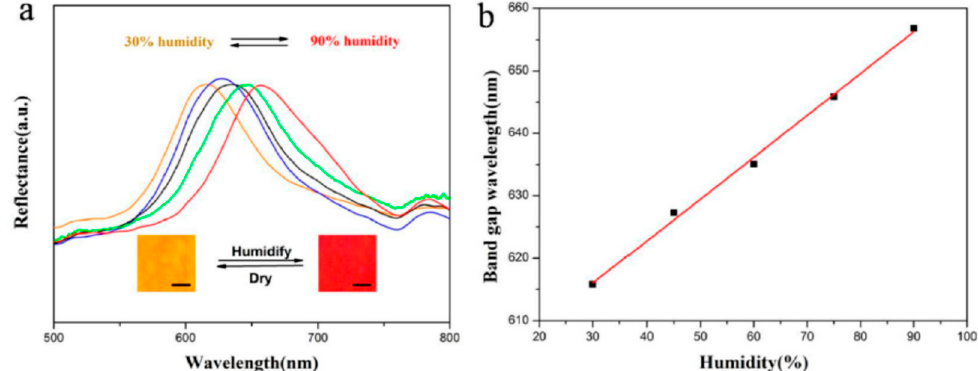
Figure 7. Response of a poly-ethylene glycol (PEG) hydrogel inverse opal as a humidity sensor: ( a ) UV-Vis reflection spectra at different RH% values (Insets show the color of the inverse opal sensor relative to 30% and 90% humidity; scale bars: 200 μ m); and ( b ) band gap wavelength as a function of the humidity. Reproduced from [48] under CC BY 4.0 License.